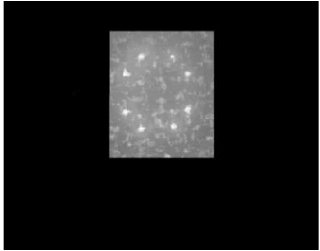
Figure 13. Result from segmentation.